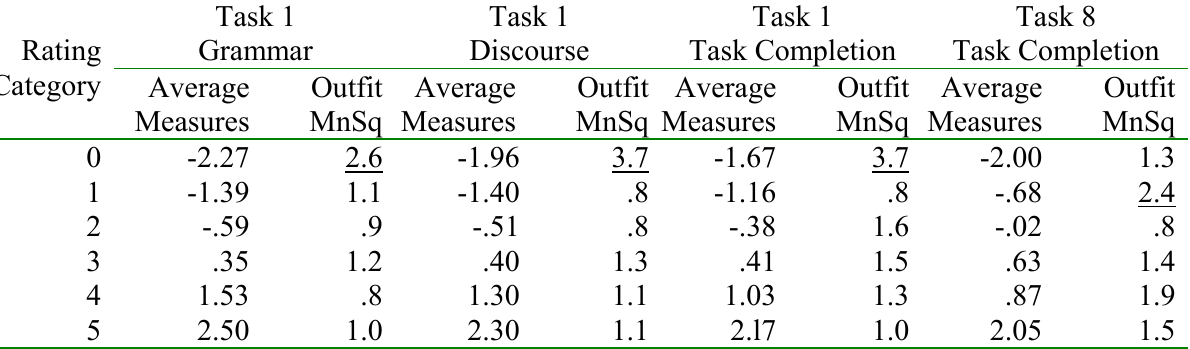
Average Examinee Ability Measures and Outfit Mean-square